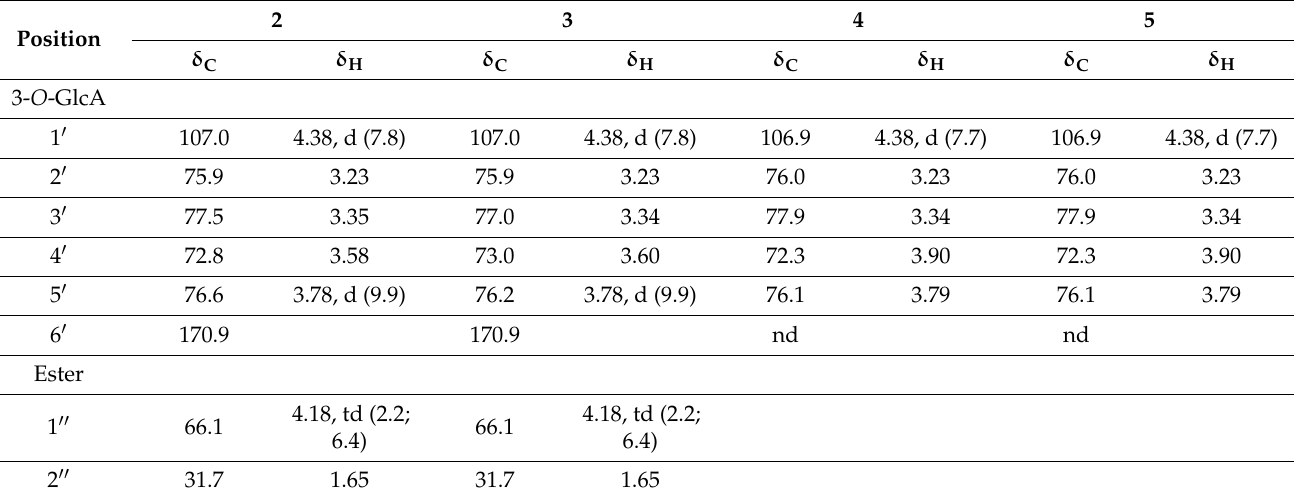
Table 3. 1 H and 13 C NMR data for the sugar moieties of 2–5 (500 and 125 MHz,